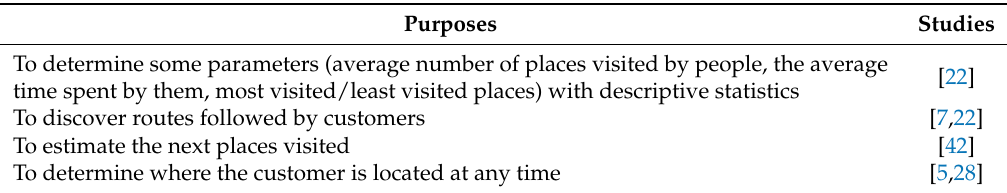
Table 1. Purpose of the collected